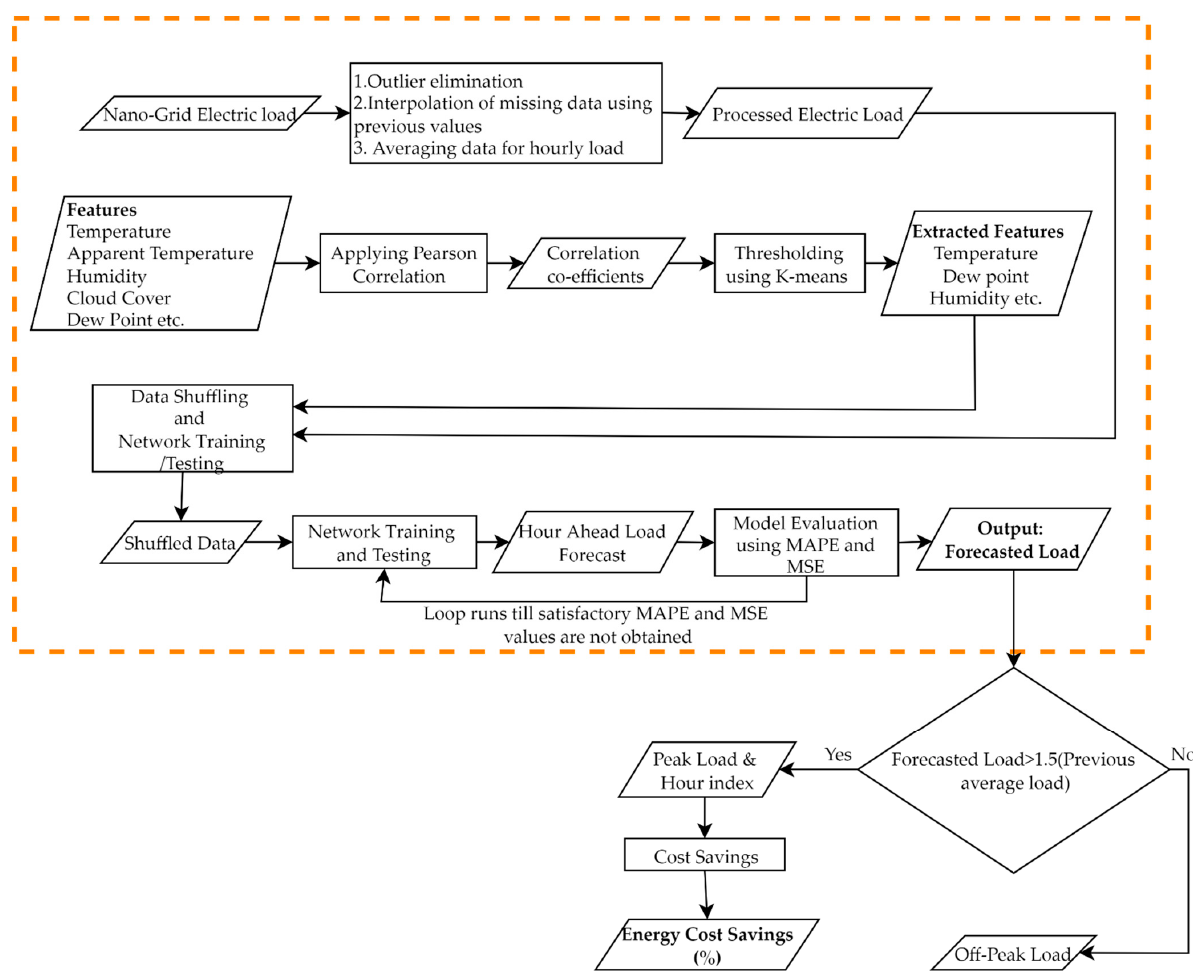
Figure 5. Schematics of the developed methodology.